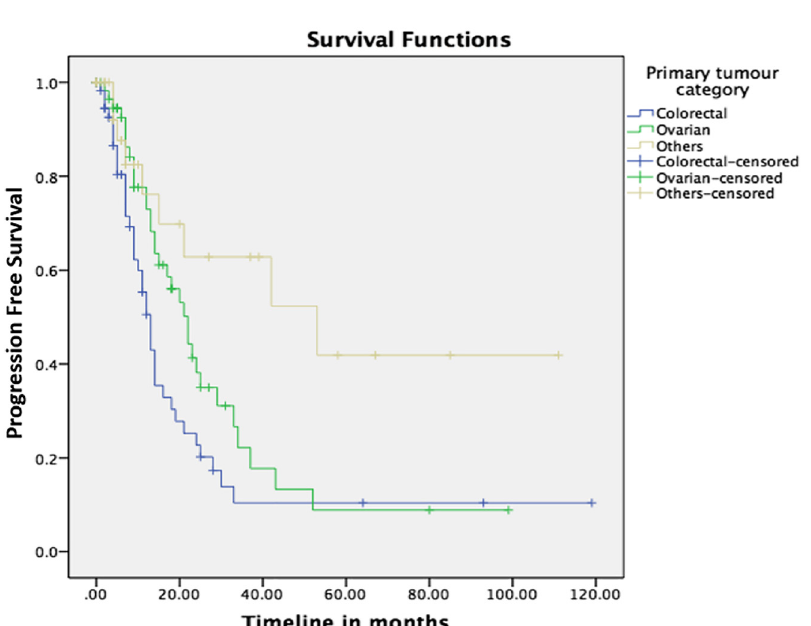
Figure 2: Overall survival (OS) of patients after CRS and HIPEC.